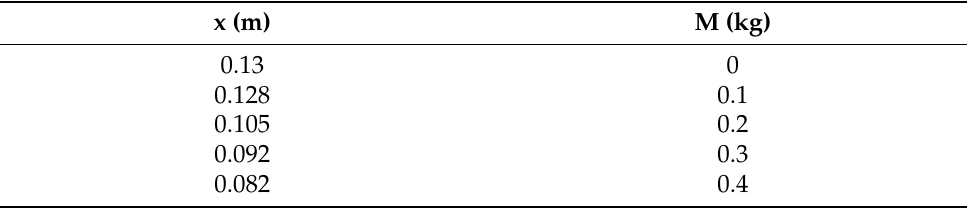
Table 1. Experimental data from spring